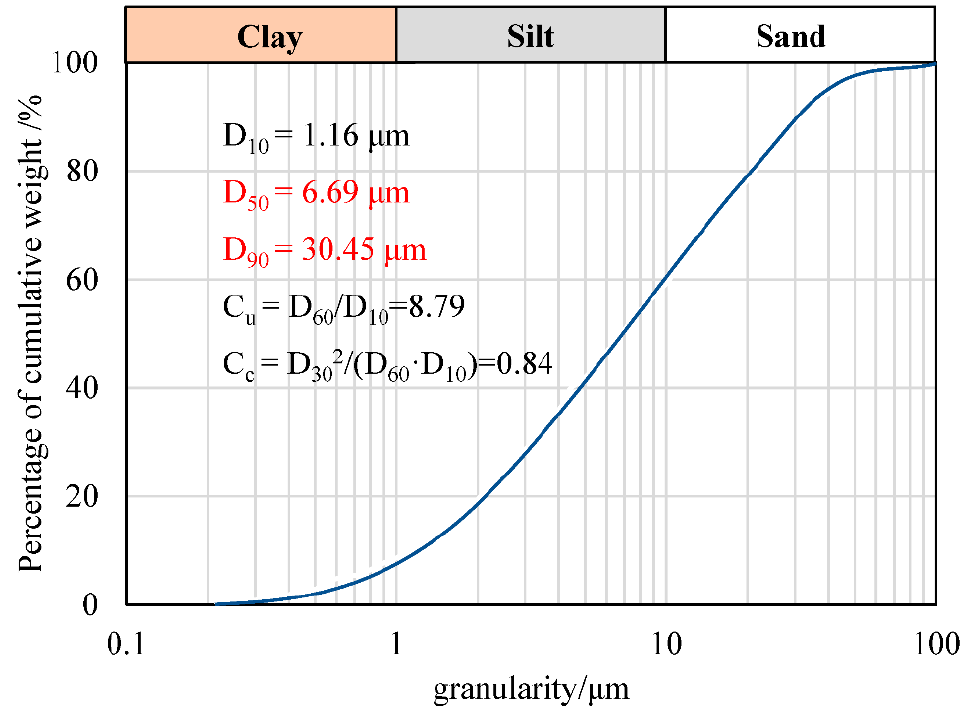
Figure 1. Particle size distribution of the filler.